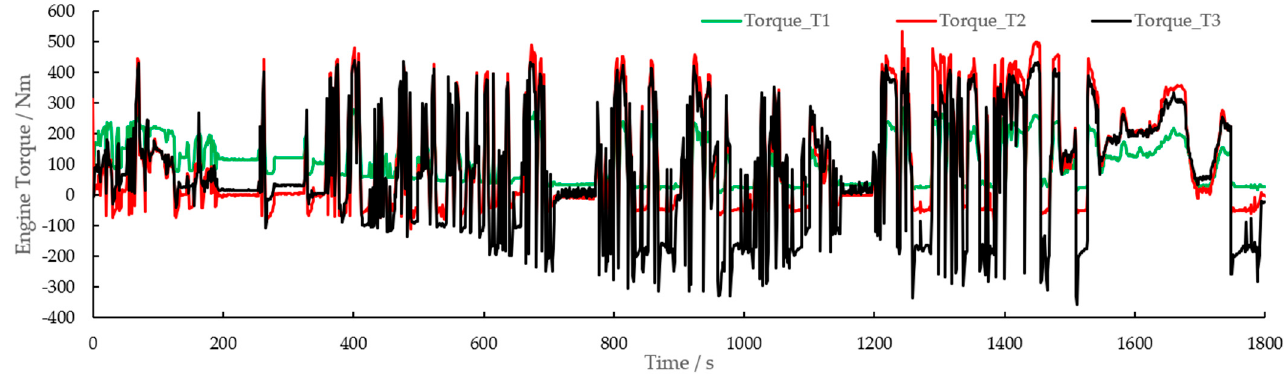
Figure 8. Effect of Ambient Temperature on Engine Torque Performance.